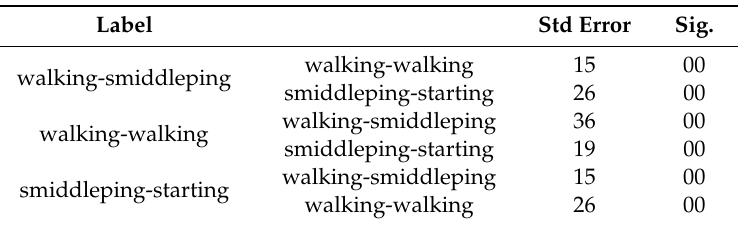
Table 2. Post-hoc comparison table.